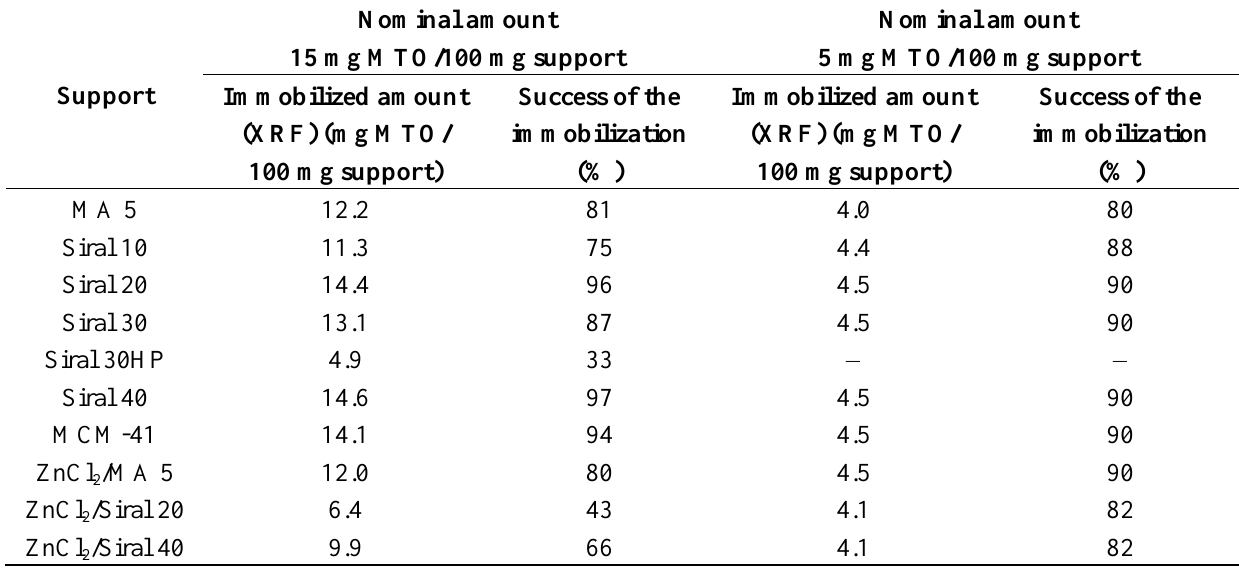
Table 1. Immobilized amounts of methyltrioxorhenium (MTO) on supports after immobilization by 5 mg and 15 mg of MTO on 100 mg of support (determined by X-ray Fluorescence (XRF) analysis).